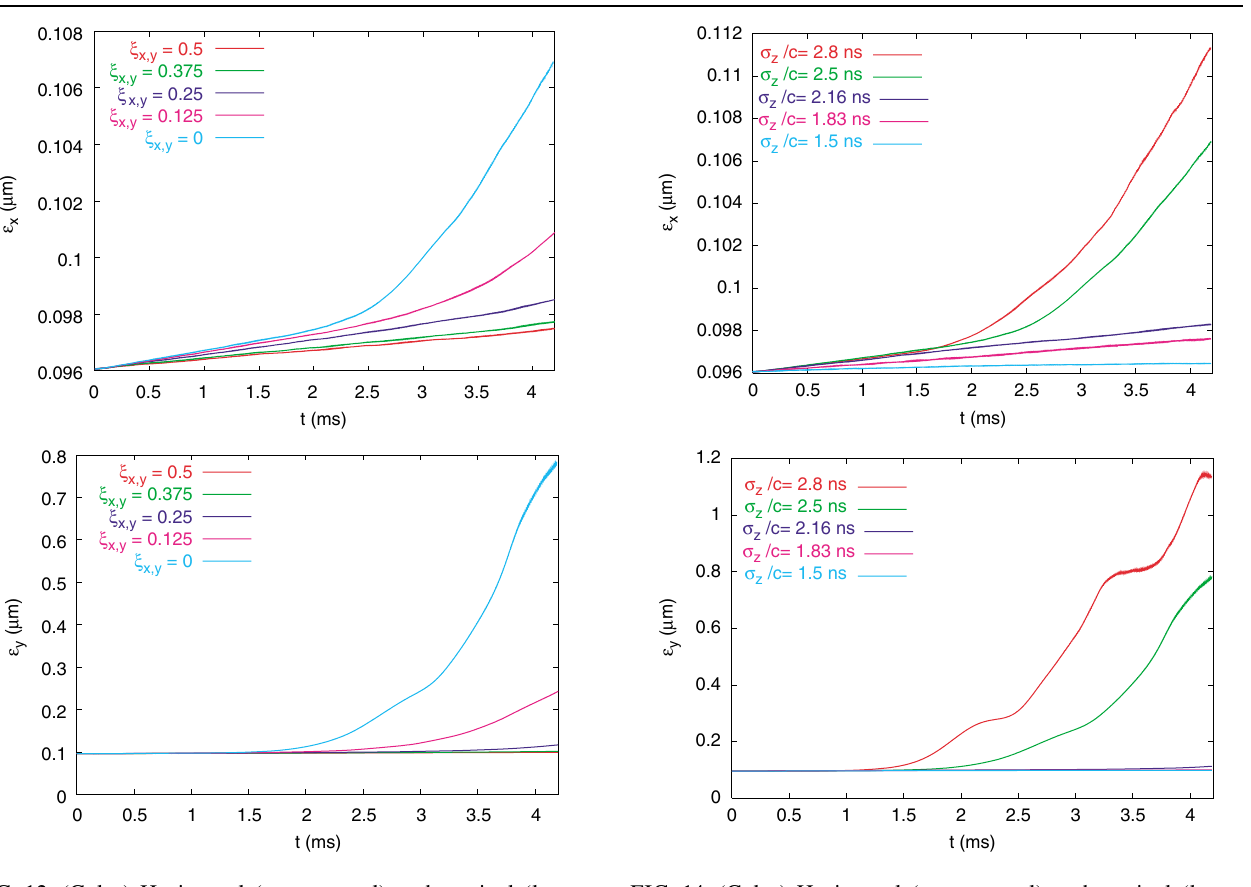
FIG. 12. (Color) Horizontal (upper panel) and vertical (lower panel) emittance growth over 2000 turns for different chro- (cid:1) 4 (cid:2) 10 10 p = b . This bunch intensity is maticities and N b slightly above the estimated instability threshold for zero chromaticity (different vertical scales are used in the two pictures).